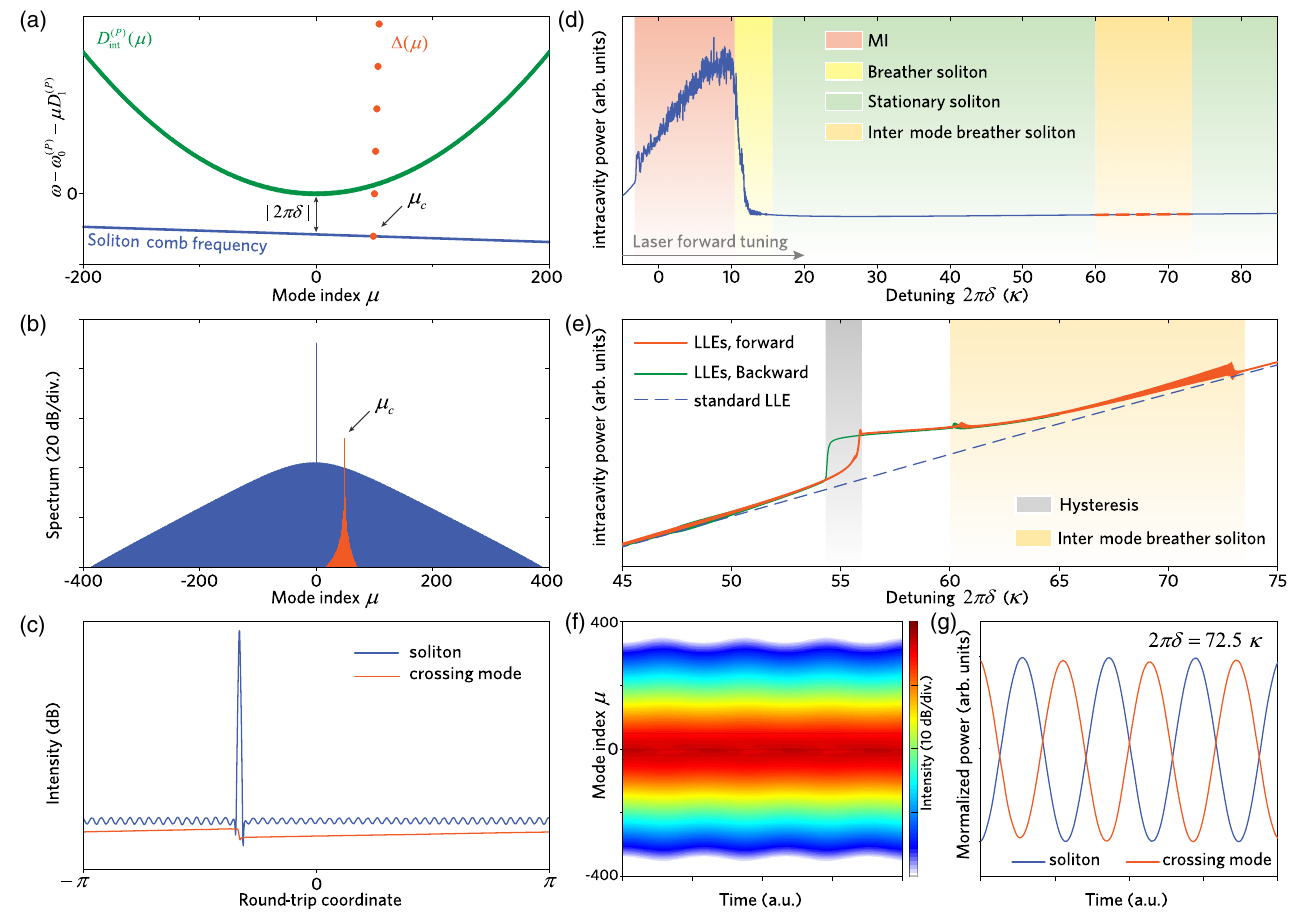
FIG. 1. Numerical simulation of an intermode breather soliton in a Kerr microresonator. (a) Integrated dispersion of a (primary) soliton-supporting mode family (green dots) in which the parabolic profile indicates the anomalous group velocity dispersion in this mode family. In the same frame, the crossing mode family shows a sloped profile corresponding to Δ ð μ Þ (red dots). Once the soliton- based frequency comb is formed with a detuning ( δ ), the soliton comb frequency represents nearly a constant ( − 2 πδ ) (blue line), implying equal distance between comb teeth. The slight slope corresponds to a change in the FSR (compared to D the soliton central frequency shift caused either by a dispersive-wave-induced soliton spectral recoil or by the Raman self-frequency shift. Thus, the phase matching between the soliton and the wave in the crossing mode ( μ soliton-based frequency comb in the primary mode family (blue lines) and a narrow band waveform in the crossing mode family (orange lines). (c) Intracavity field patterns in both mode families. (d) Intracavity power trace over the laser detuning, based on a standard LLE model in the absence of intermode interactions (blue line). Three stages, modulation instability (MI) regime (red area), breather soliton (yellow area), and stationary soliton (green area), are marked as typical transitions of frequency comb states in the generation process. The intermode breather soliton exists in the region where stationary DKS would be expected (orange area). (e) DKS in the presence of intermode interactions (based on the coupled LLEs model) show a different behavior, including a hysteretic power transition (gray area) and an oscillatory behavior (orange area). (f) Spectral envelope evolution of a single intermode breather soliton. (g) Out-of-phase oscillations in the energy of the soliton and the crossing mode